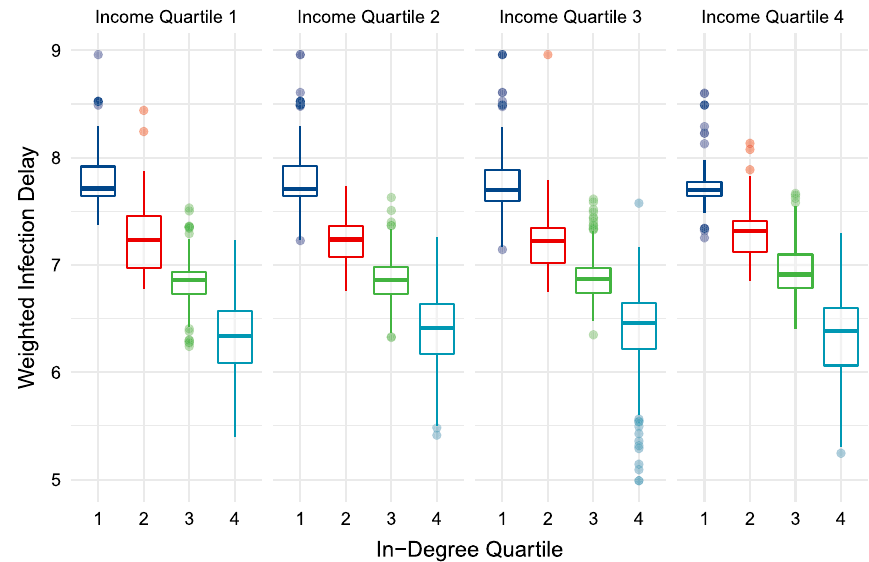
Fig. 7 Weighted median infection delay values across in-degree centrality quartiles, while controlling for income